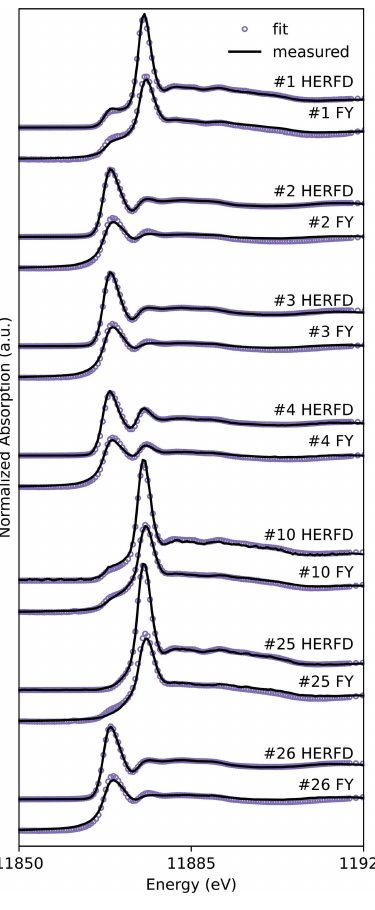
Figure 5 A comparison between the fits obtained with LCF for seven As-bearing tailings samples for both HERFD and FY